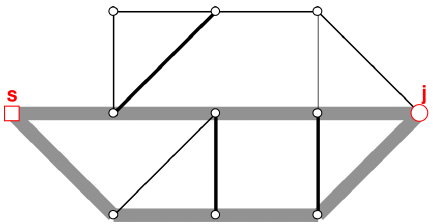
Figure 8. Graph with updated weights after first and second short- est path are identified (thick grey lines indicate edges with updated weights).